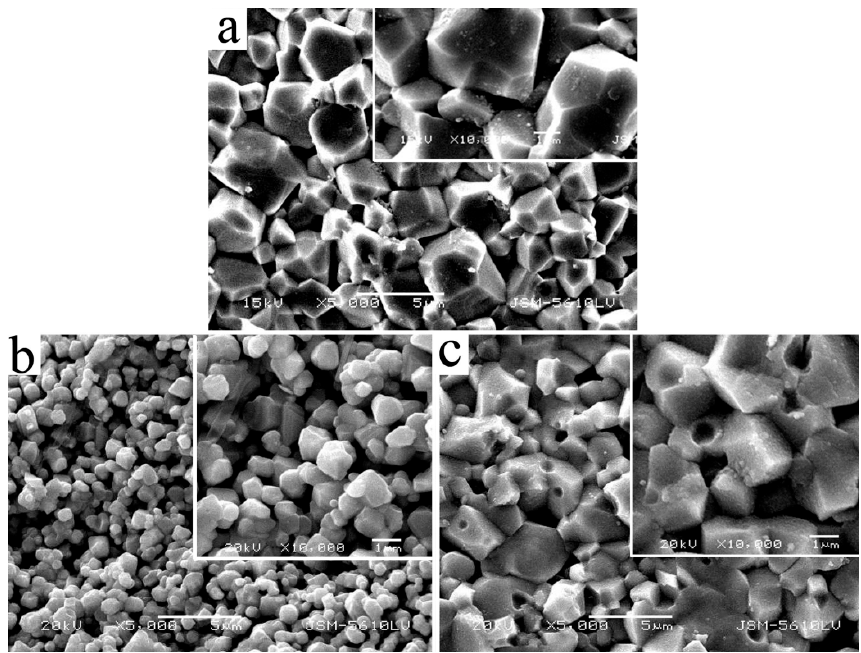
Figure 3. SEM micrographs of fracture surfaces of La 0.8 Ca 0.2 CrO 3 ceramics. ( a ) Sintered at 1400 °C and by the combustion method; ( b ) sintered at 1400 °C and by the high temperature SSR method; ( c ) sintered at 1500 °C and by the high temperature SSR